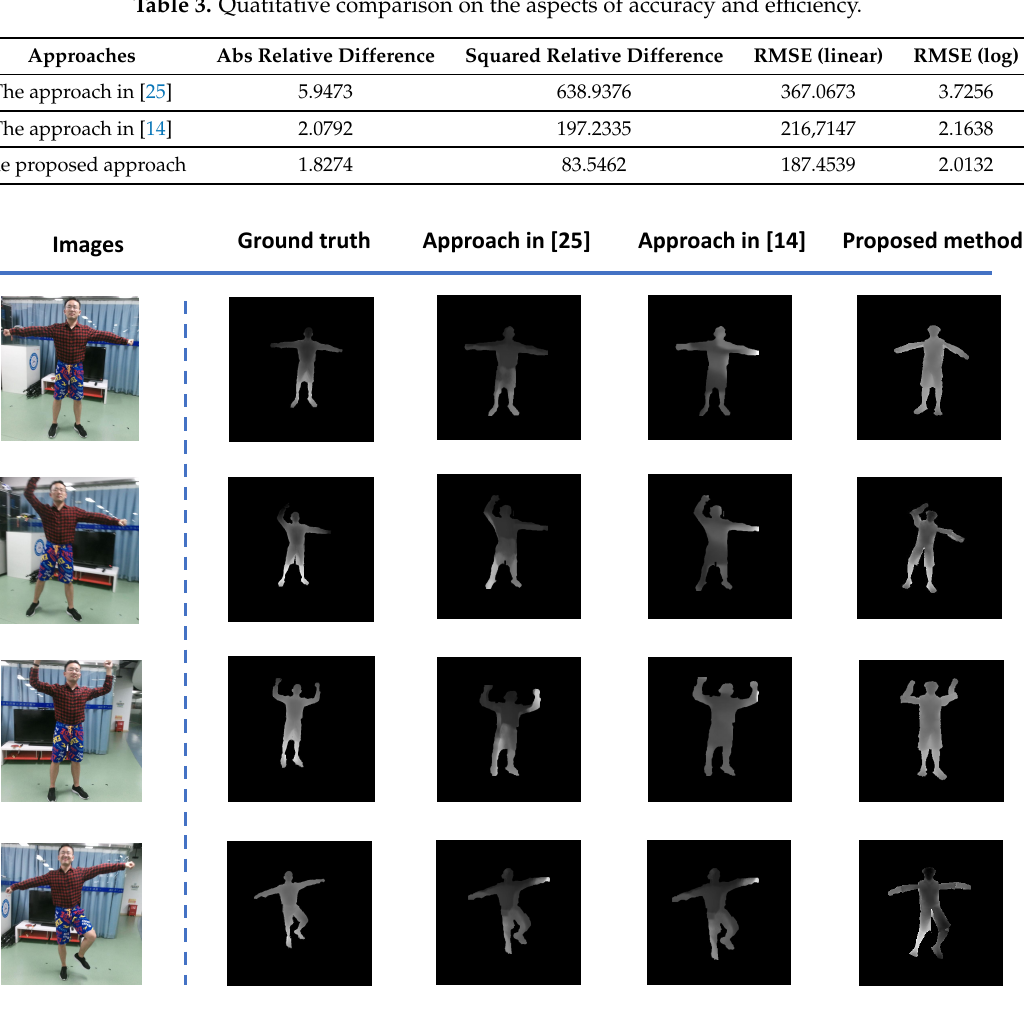
Figure 6. The depth estimation results for the human volunteer by the approaches in [14,25] and the proposed